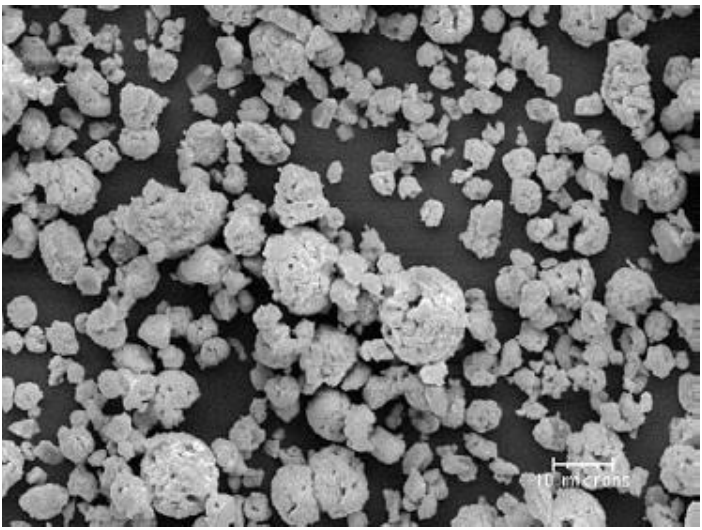
Figure 1. 7.5 wt.% yttria partially stabilized zirconia powder (YSZ); powder M6700 (Oerlikon Metco, Zurich, Switzerland).